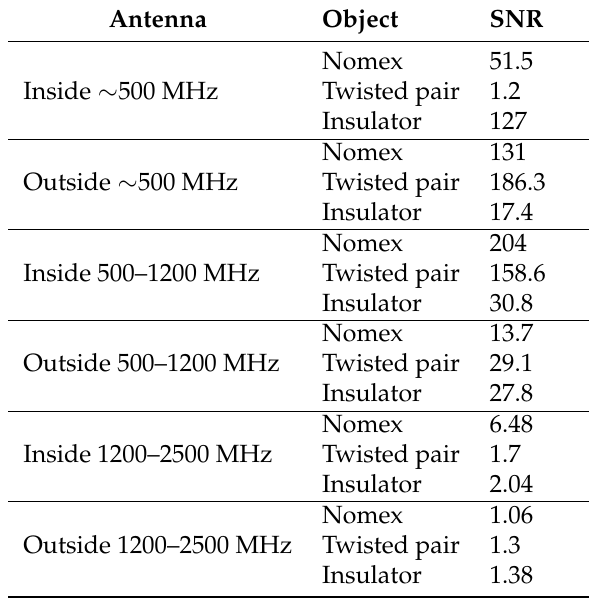
Table 11. SNRs for the three test objects measured from inside and